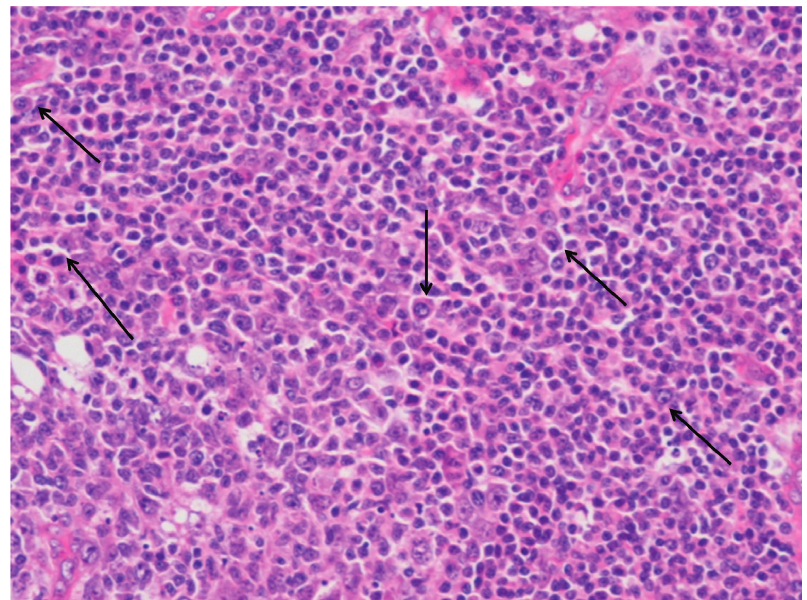
Figure 2: Hematoxylin and eosin stain, original magnification × 40. Sheets of mature plasma cells and a few plasmablasts with large nuclei, vesicular chromatin, and prominent nucleoli (arrows) are also seen in the interfollicular